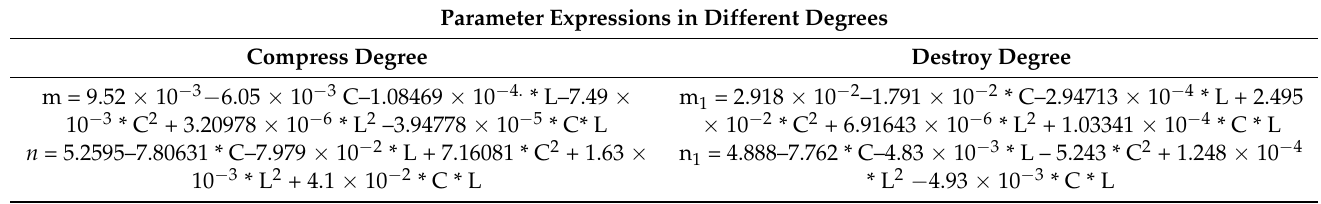
Table 6. Calculation results of the parameters m, n, m 1 , and n 1